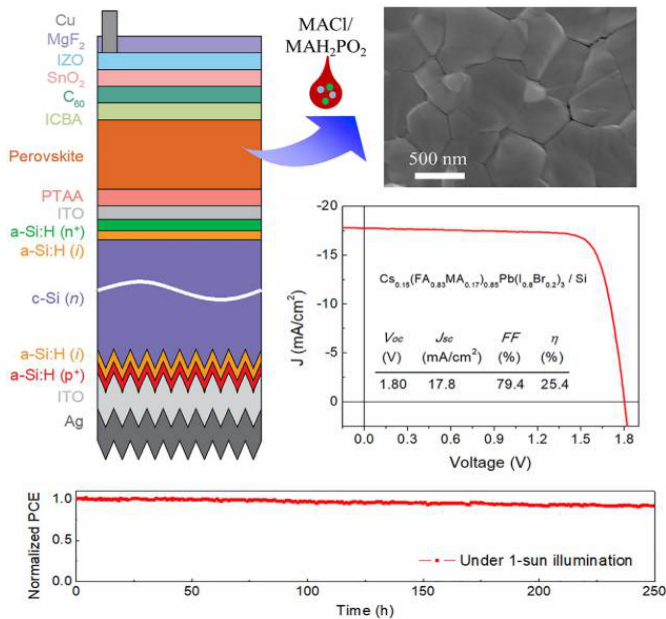
Figure 8. The structure and performance of the two-terminal tandem solar cell [72].